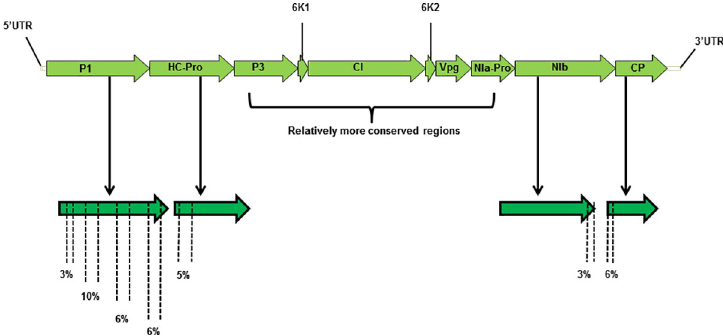
Fig 6. Approximate genetic variation in the individual gene fragments of